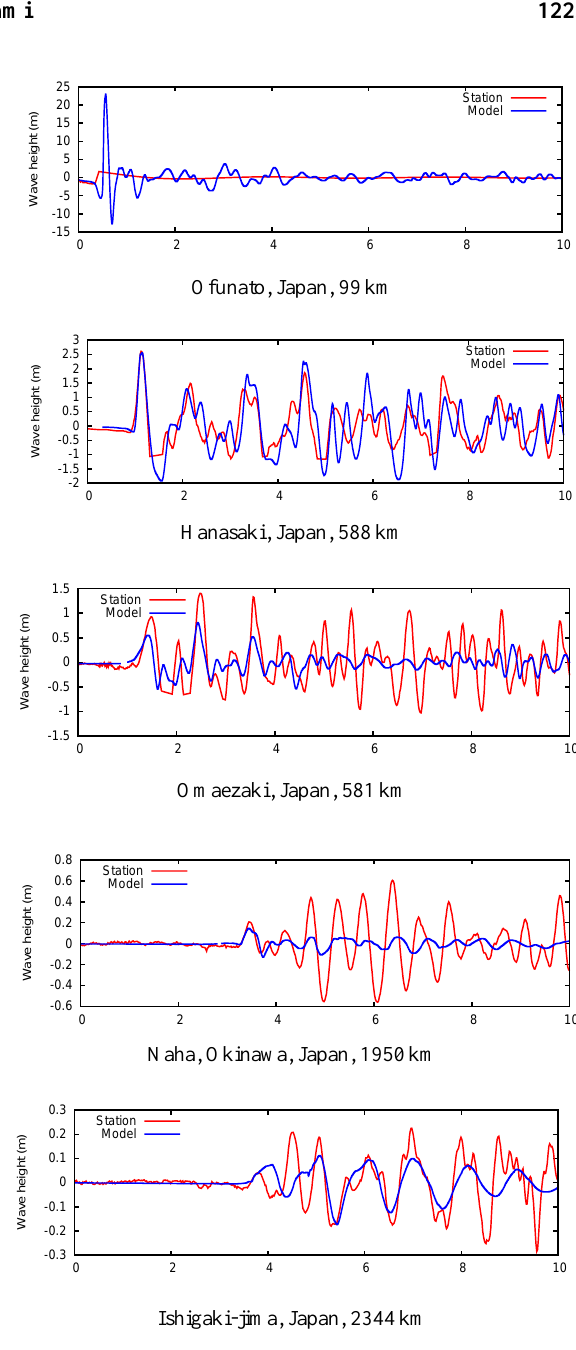
Fig. 13. Measured and modelled timeseries at GLOSS stations loca- tions. Horizontal axis is time in hours. Distances from the epicentre are indicated in the